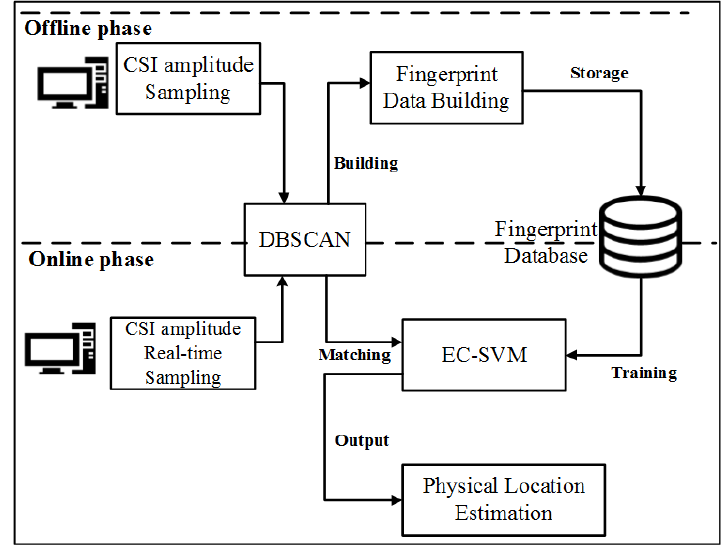
Figure 3. Localization